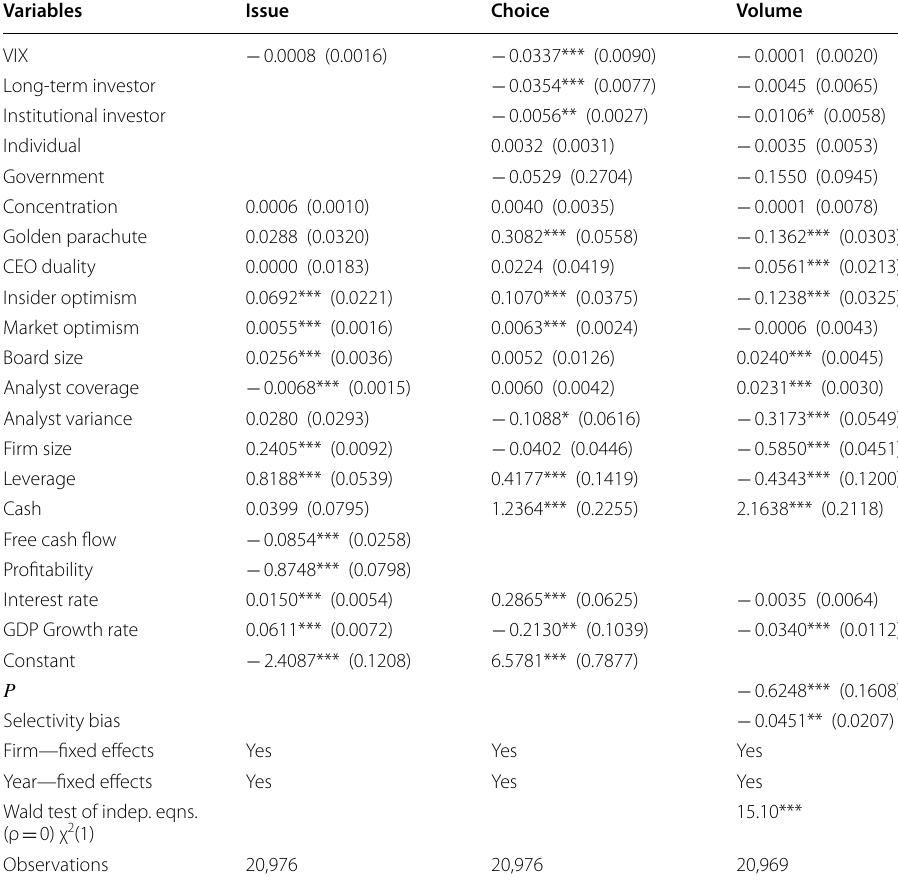
Table 9 Empirical estimations based on the Heckman three-stage ordered probit model with firm- fixed effects and year-fixed effects and robust standard